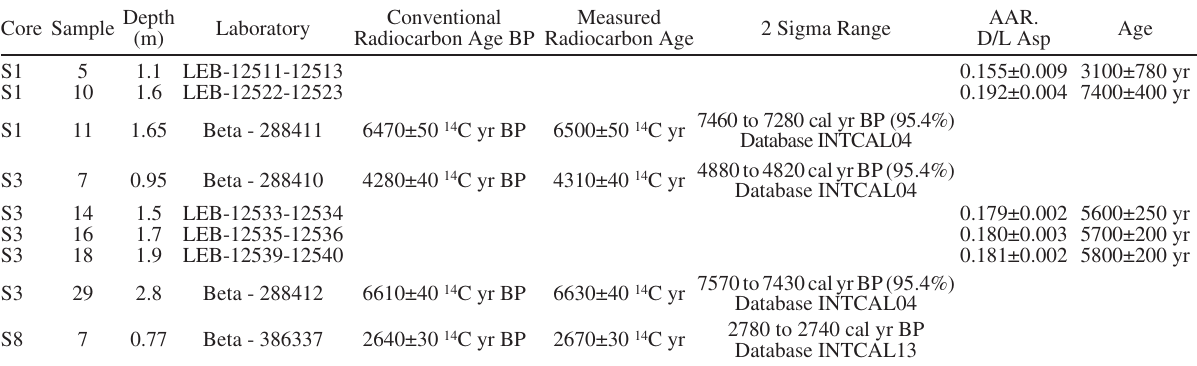
Table 1. – Radiometric datings. 14 C (Beta Analytic, Florida, US) and amino acid racemization (AAR) (Laboratory of Biomolecular Stratigra- phy, Madrid, Spain). Modified from Blázquez et al. (2017). Depth Core Sample (m)